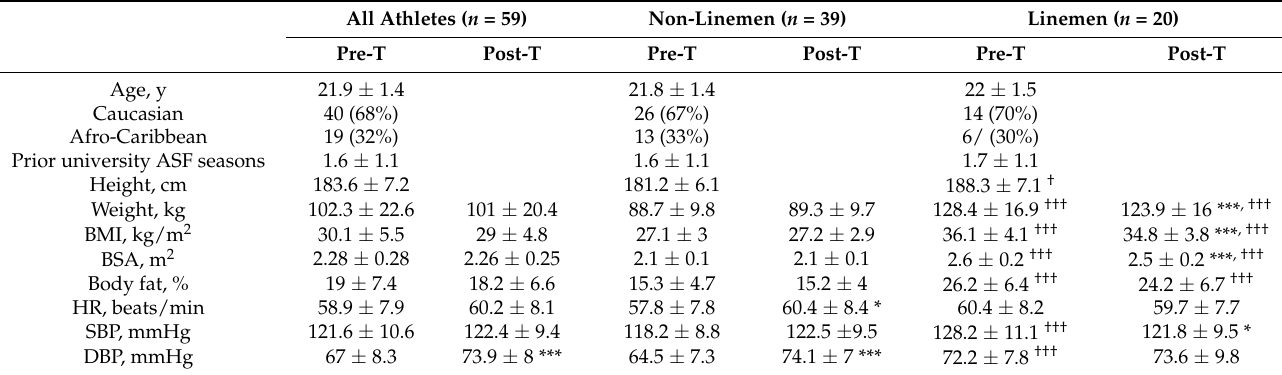
Table 1. Comparison of pre-training (pre-T) and post-training (post-T) clinical data. All Athletes ( n = 59) Non-Linemen ( n =